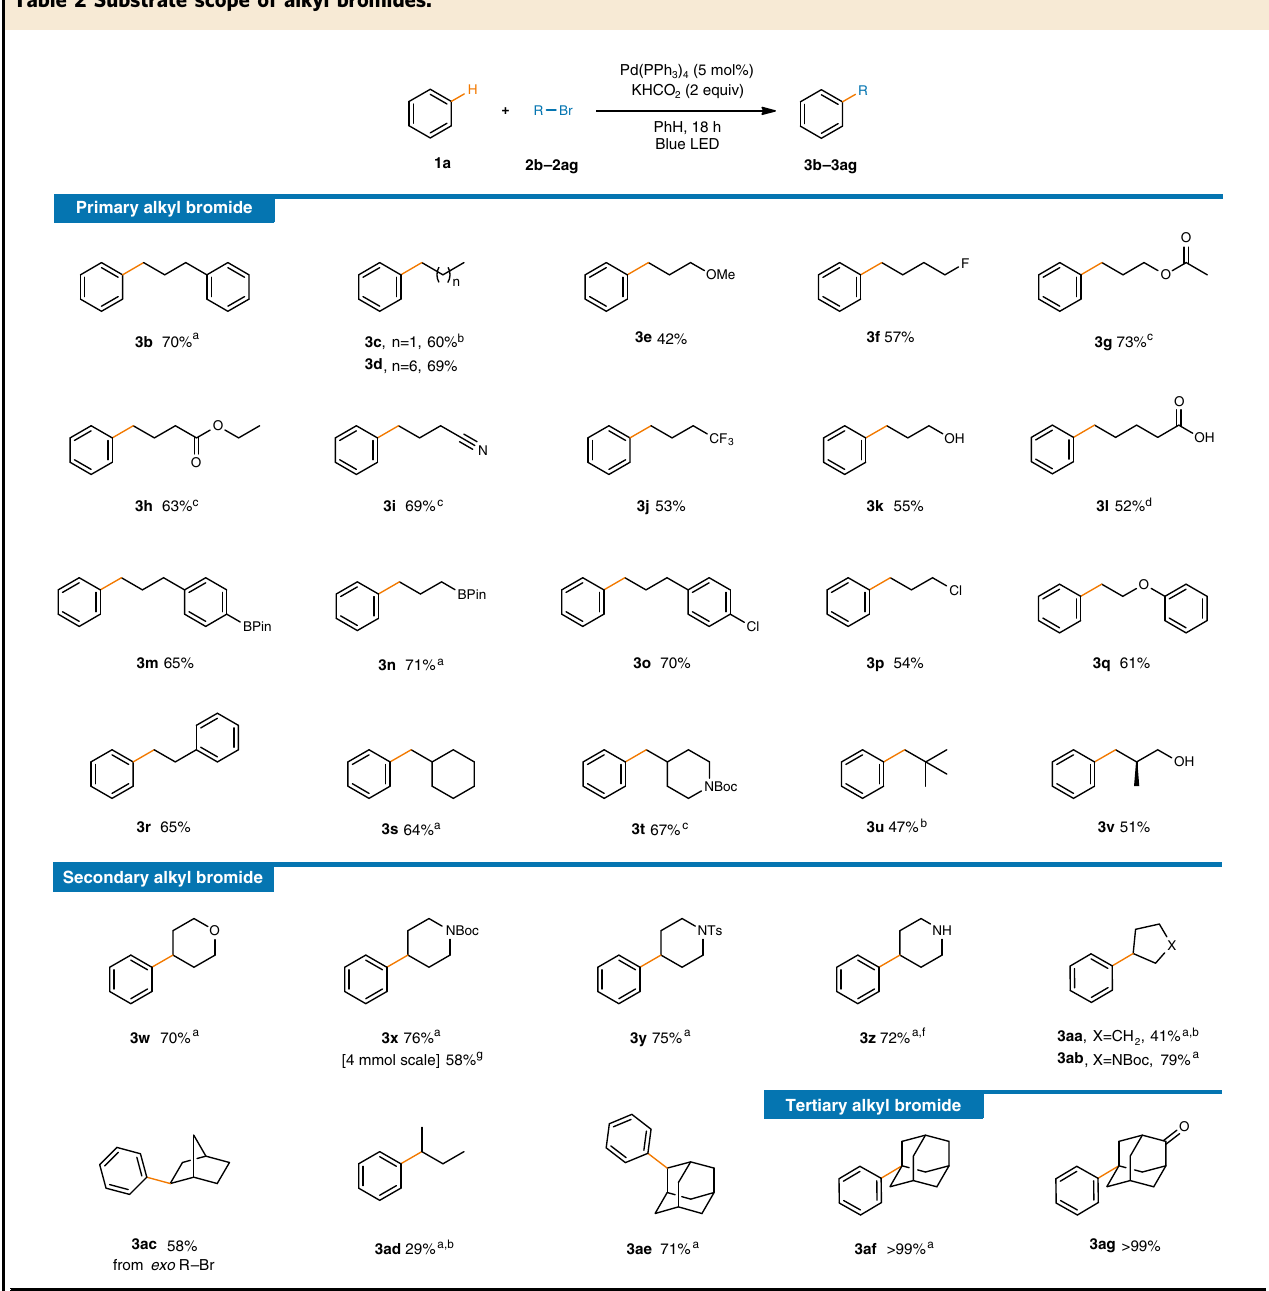
Table 2 Substrate scope of alkyl